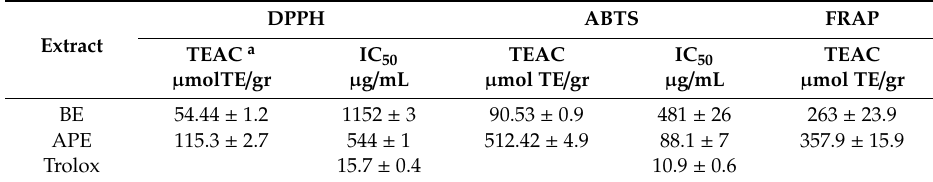
Table 2. Antioxidant activity of the ethanolic extracts from bulb (BE) and aerial parts (APE) of A. subhirsutum.